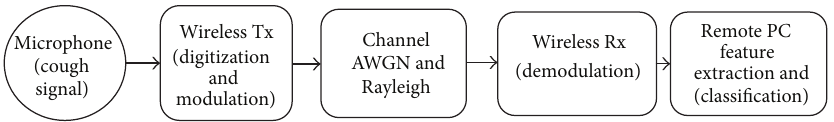
Figure 1: Block diagram of a wireless monitoring system for asthma attack detection.